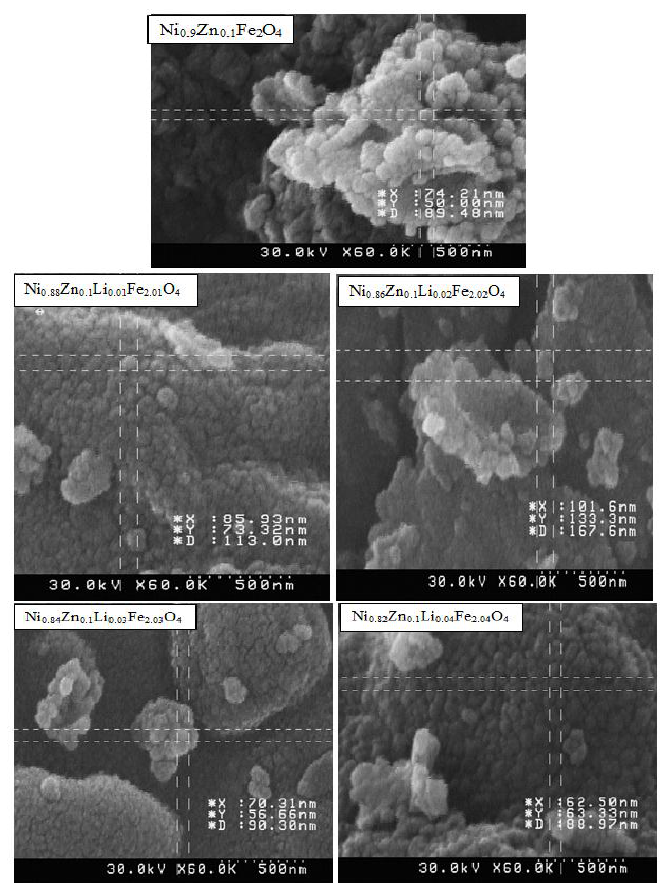
Fig. 5: SEM images of synthesized nickel-zinc-lithium ferrite